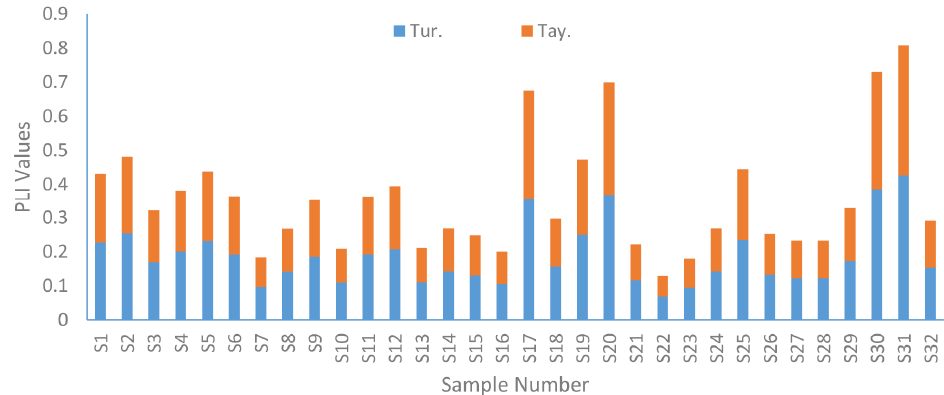
Figure 5. Results of PLI in the study area based on background values [37,38]. Table 4. Distribution of samples in the ranges established by the SQG, according to the PTE concen- trations (mg/kg).